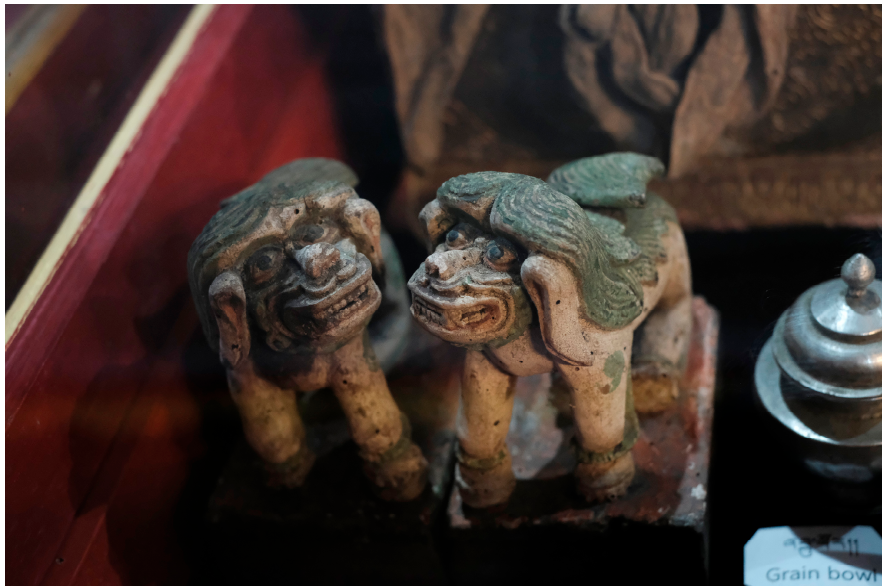
Figure 4. Two small snow lion figures exhibited at Tharpa Chöling Monastery Museum. Kalimpong, December 2018. Photo by author.